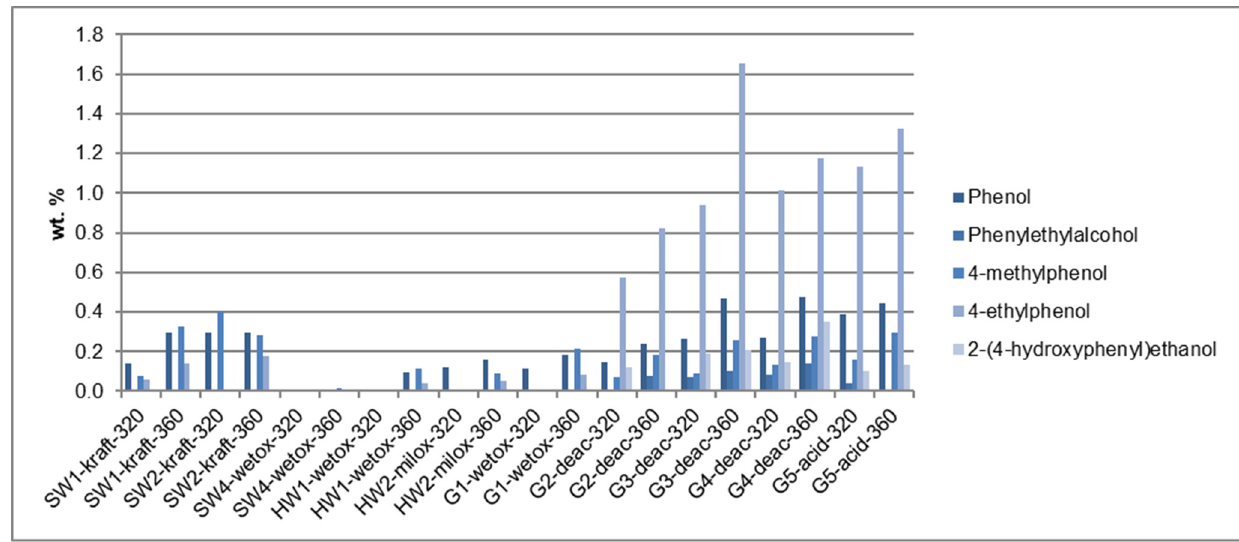
Figure 6. Quantification of phenol, selected substituted phenols and 2-(4-hydroxyphenyl) ethanol in the produced bio-oils, given as wt.% in the obtained bio-oil.